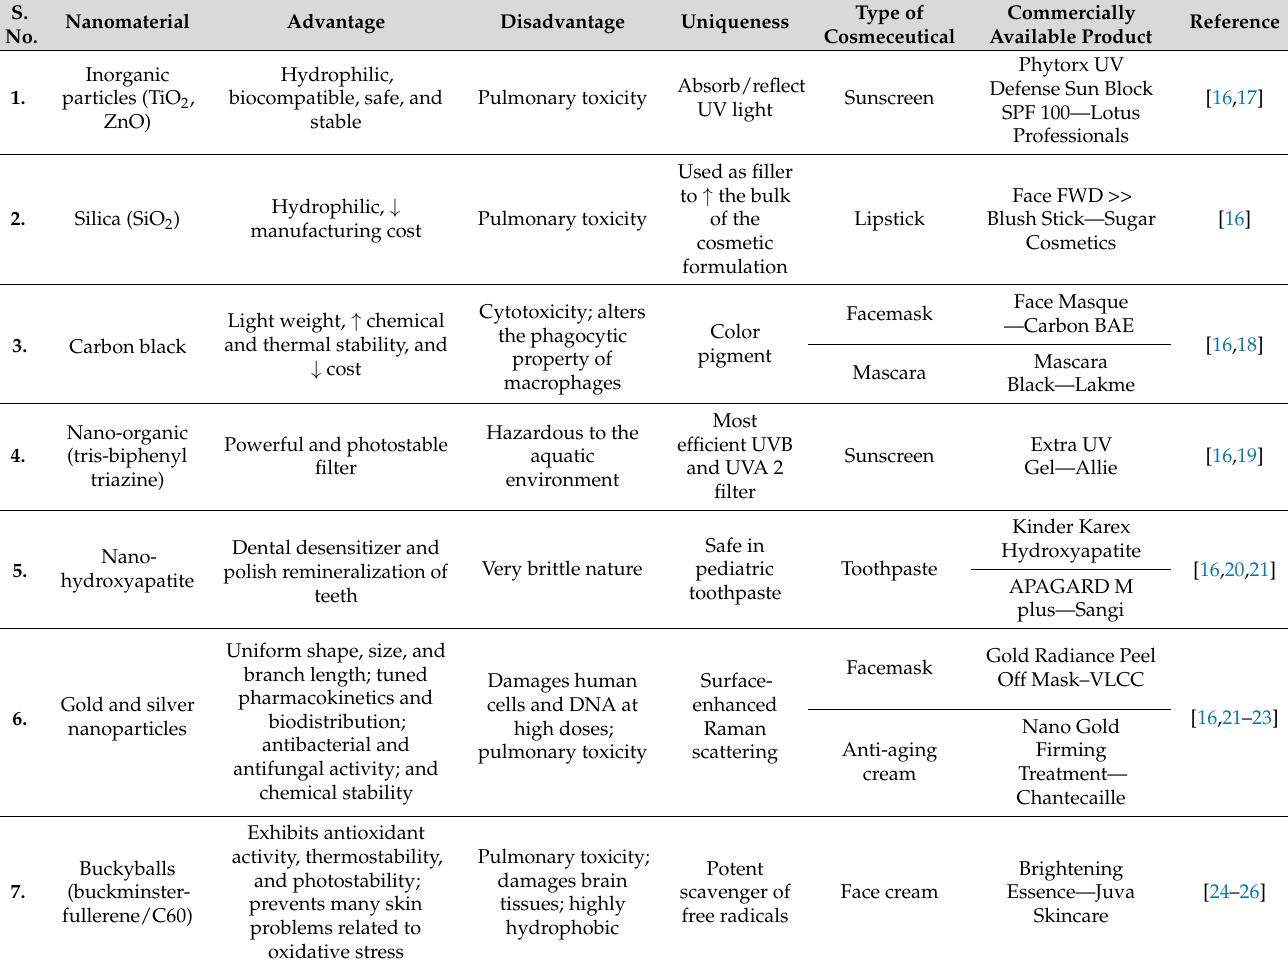
Table 1. Different nanomaterials used for preparing cosmetics and